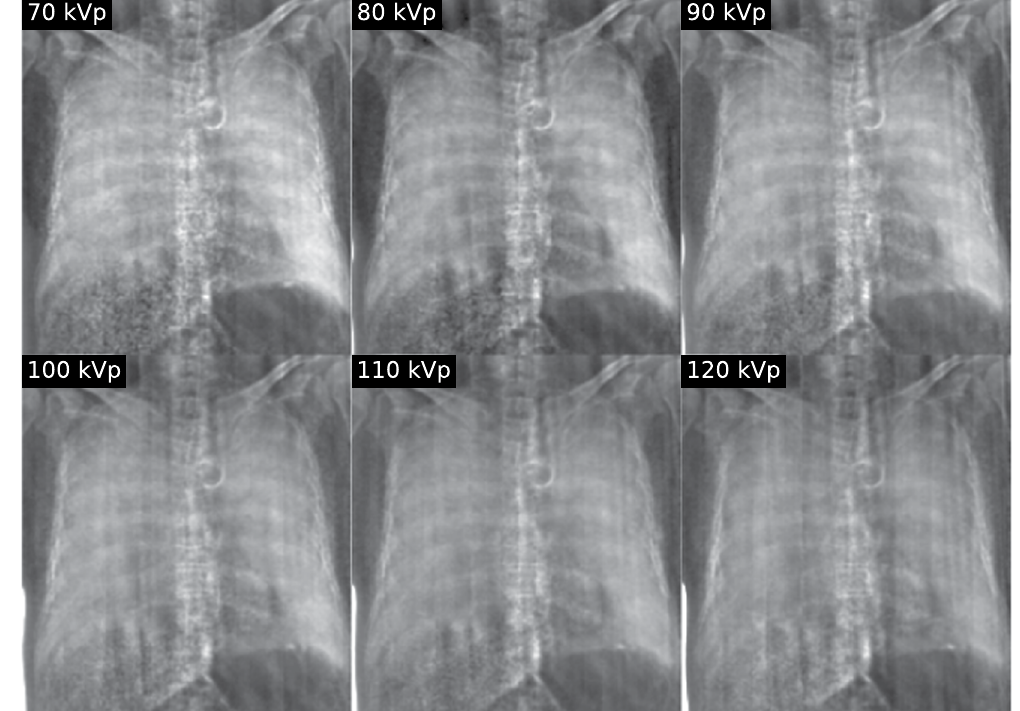
Figure 2. X-ray dark-field radiographs of a human thorax at the examined tube voltages. All images presented here and in Fig. 1a are shown with the same windowing and the same low-pass filter as in Fig. 1a was applied. The dark-field signal declines significantly toward higher tube voltages. Also, the image quality decreases with higher tube voltages due an increase of imaging